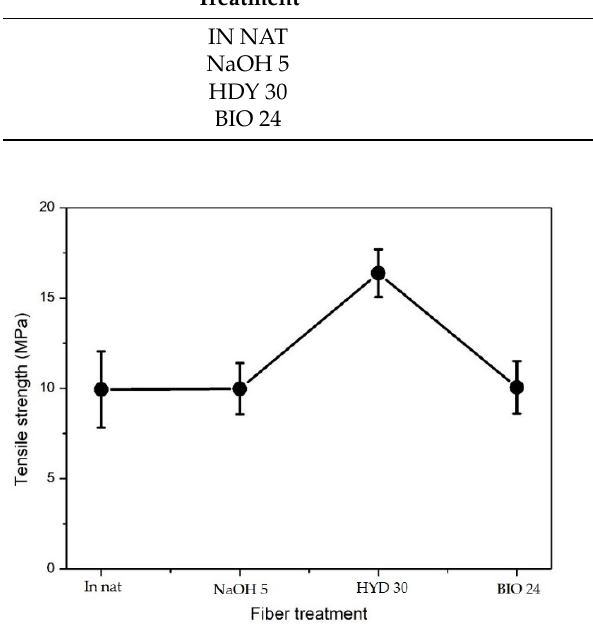
Figure 11. Tensile strength of composites with 20% treated and untreated CHFW.